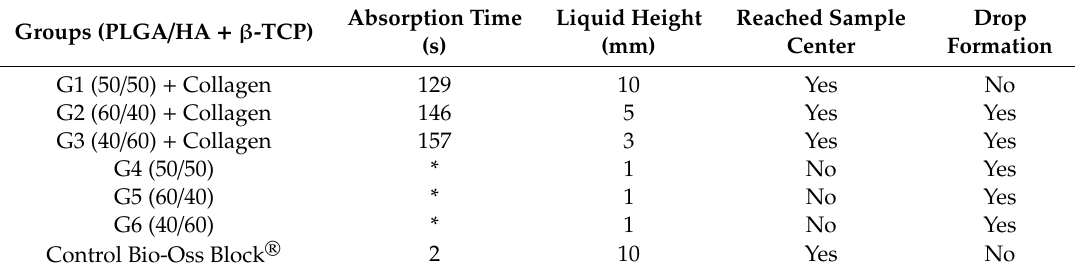
Table 2. Characterization of the wettability of the composite and control groups. In the groups without collagen impregnation there is no liquid absorption (*).